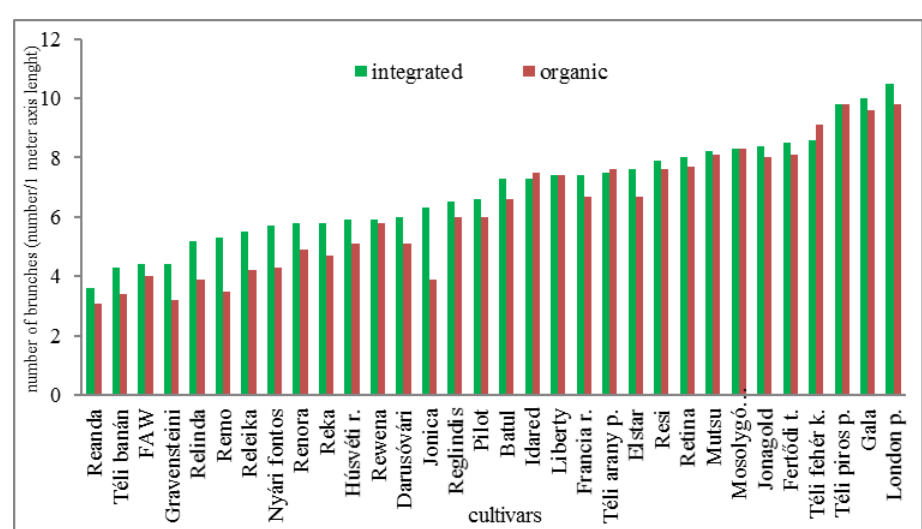
Figure 3. Number of branches of the central axis in the middle third of the canopy (Debrecen-Pallag,